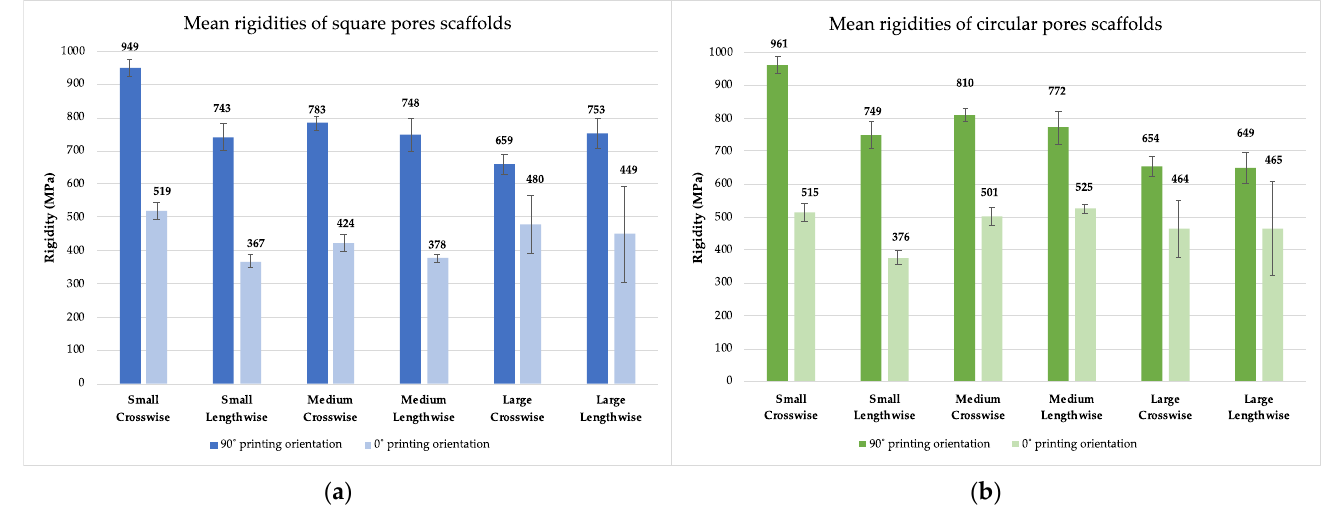
Figure 4. ( a ) Mean rigidities of square pores’ scaffolds; ( b ) mean rigidities of circular pores’ scaffolds. Error bars represent ± standard deviation, n = 5.